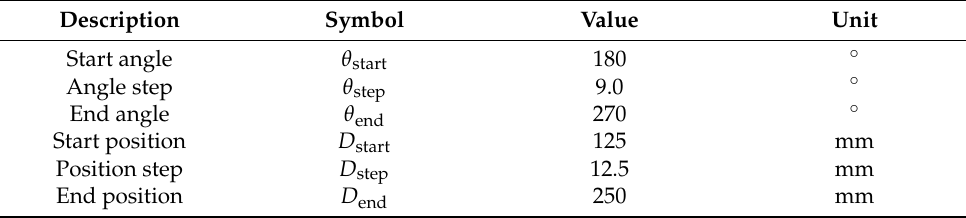
Table 3. Simulation parameters for the FEM optimization.